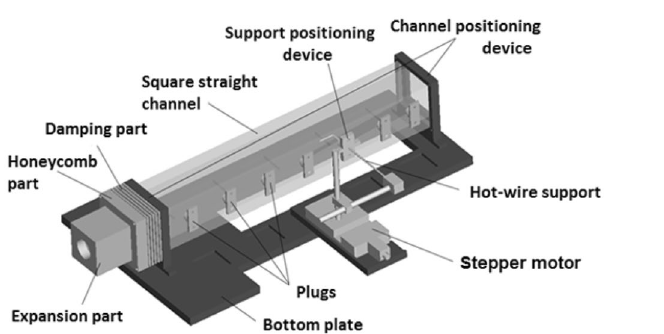
Figure 1. Schematic diagram of the rotating facility.